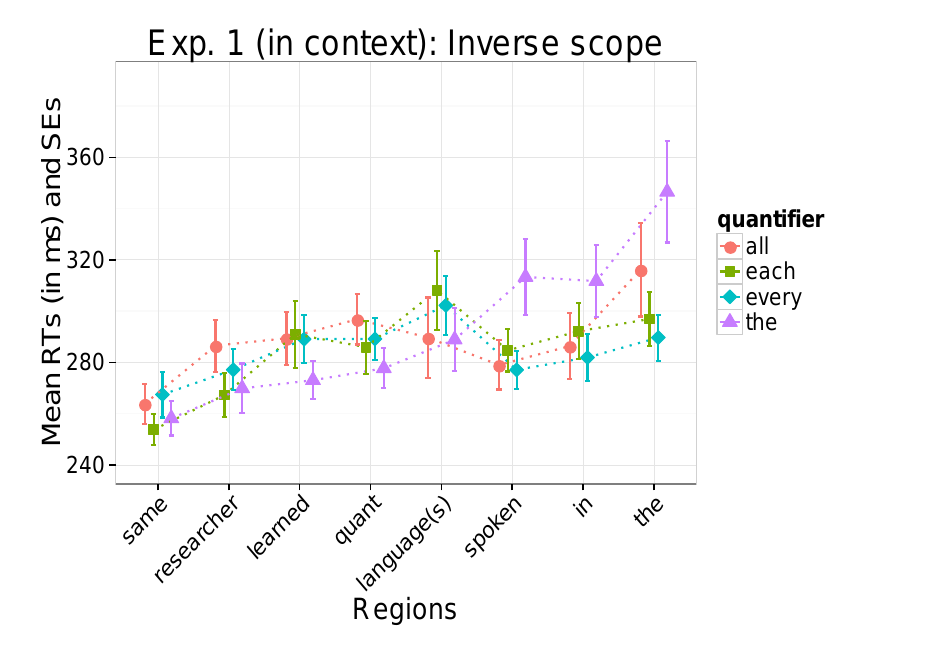
Figure 3 Mean RTs and SEs for all ROIs in Experiment 1 (in context); inverse scope